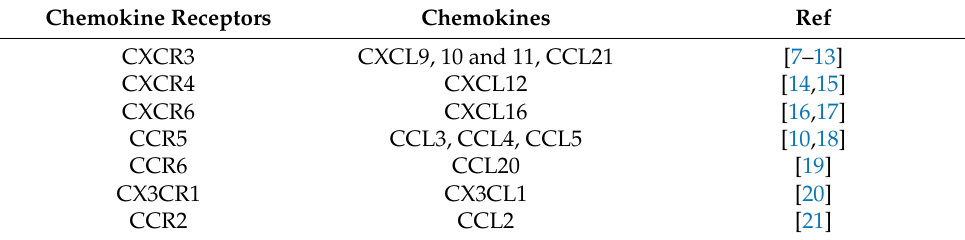
Table 1. Main receptor/chemokine described to participate in CD8 T-cell migration. Chemokine